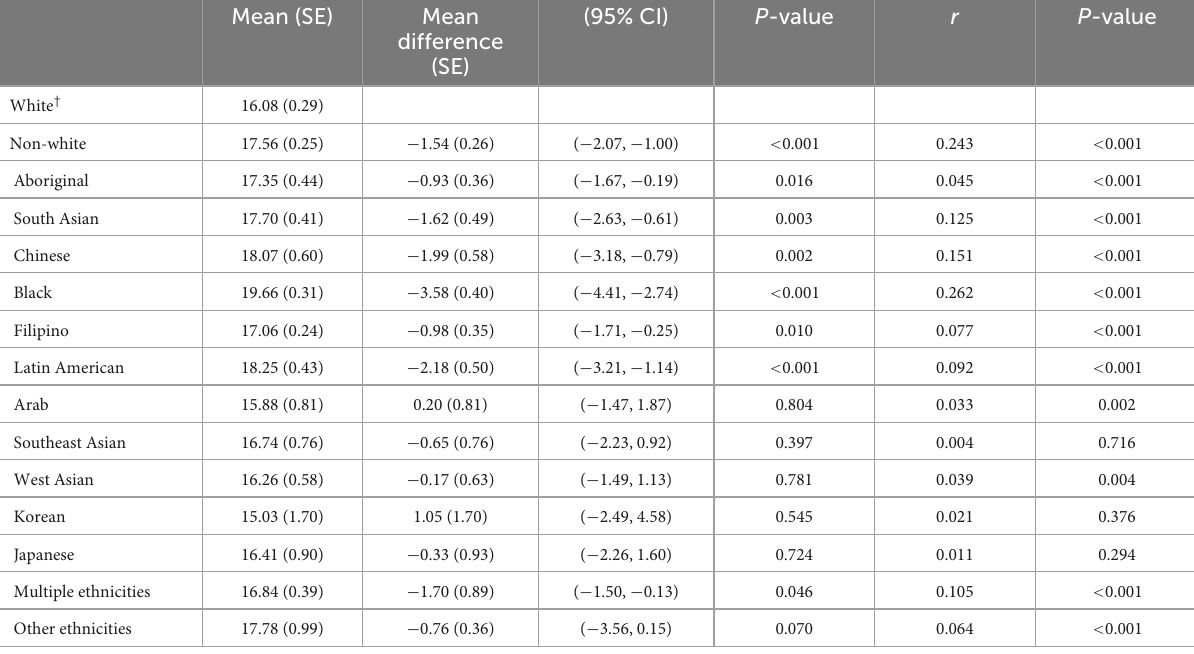
TABLE 2 Weighted mean melanin levels by ethnicity using Canadian Health Measures Survey (CHMS) data (Cycles 3 and 4). Mean (SE) Mean (95% difference (SE)